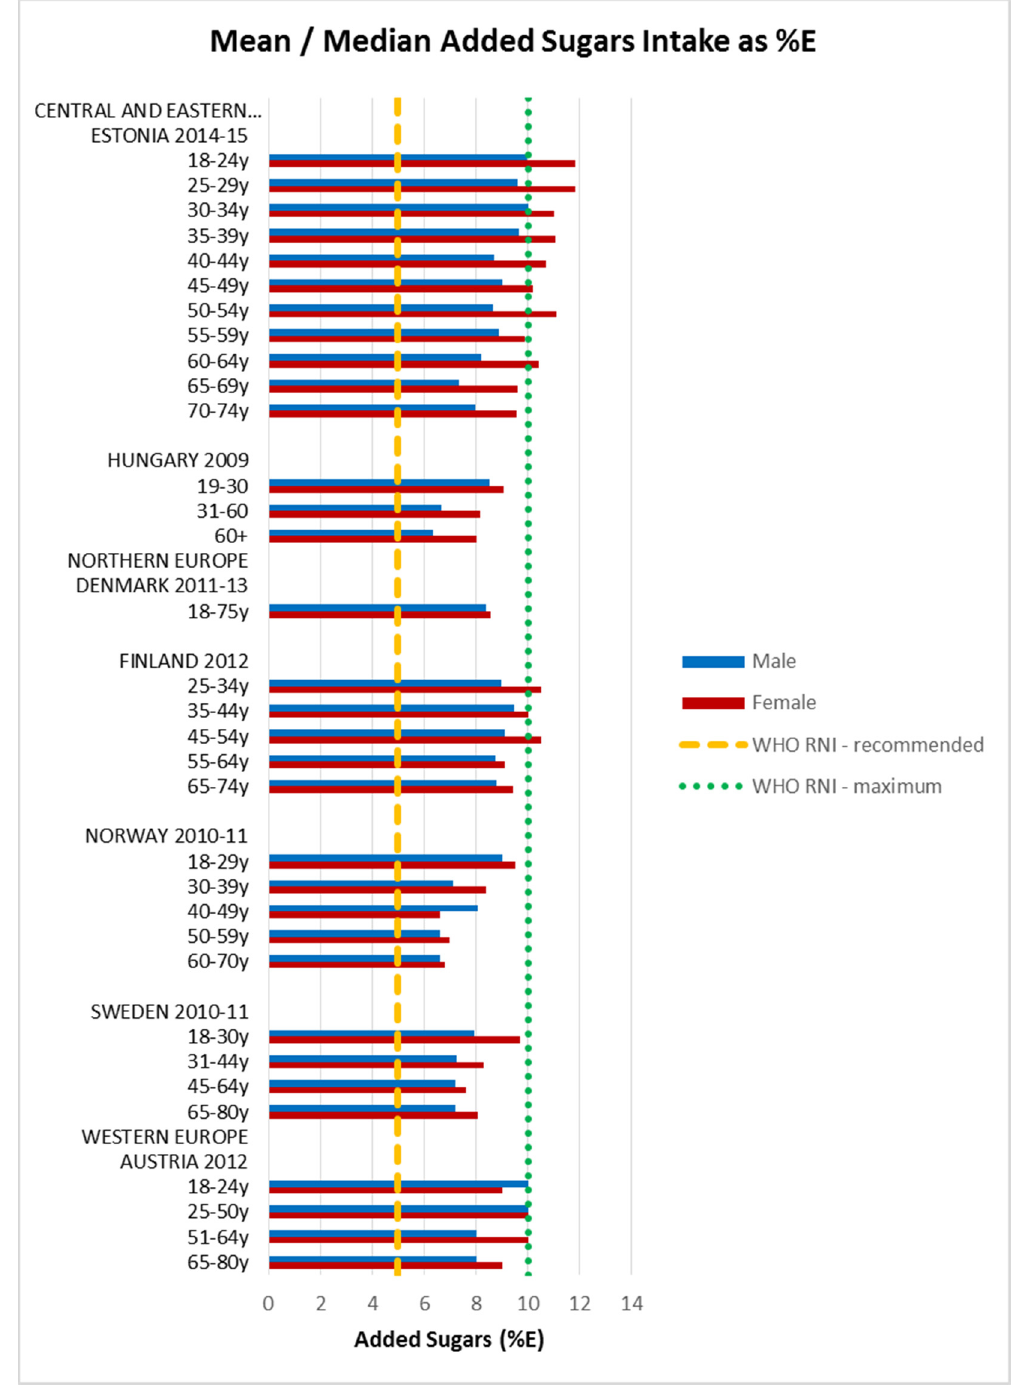
Figure 6. Mean/median adult added sugars intake (g/day) (excluding supplements).